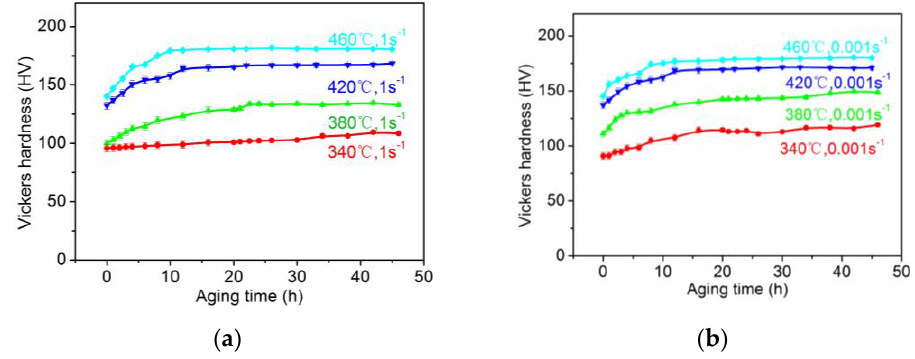
Figure 7. Hardness variation of the hot-compressed samples with an aging time at 120 °C . The samples were compressed with strain rates of: ( a ) 1 s −1 ; and ( b ) 0.001 s −1 .